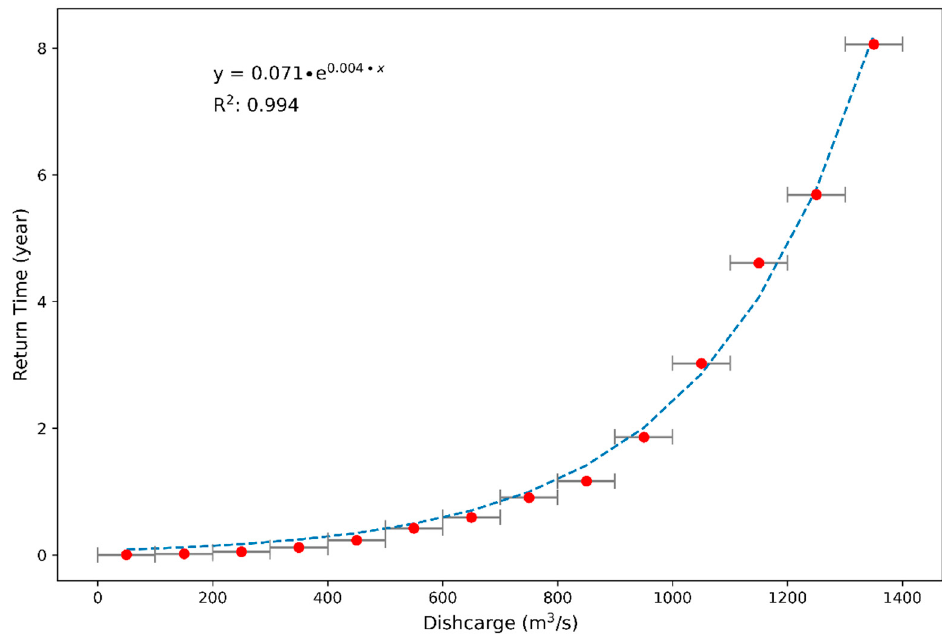
Figure 5. Return times for discharge intervals of the S. Giovanni alla Vena time series. Discretiza- tion of the discharge range in 100 m 3 /s. The return times show an exponential